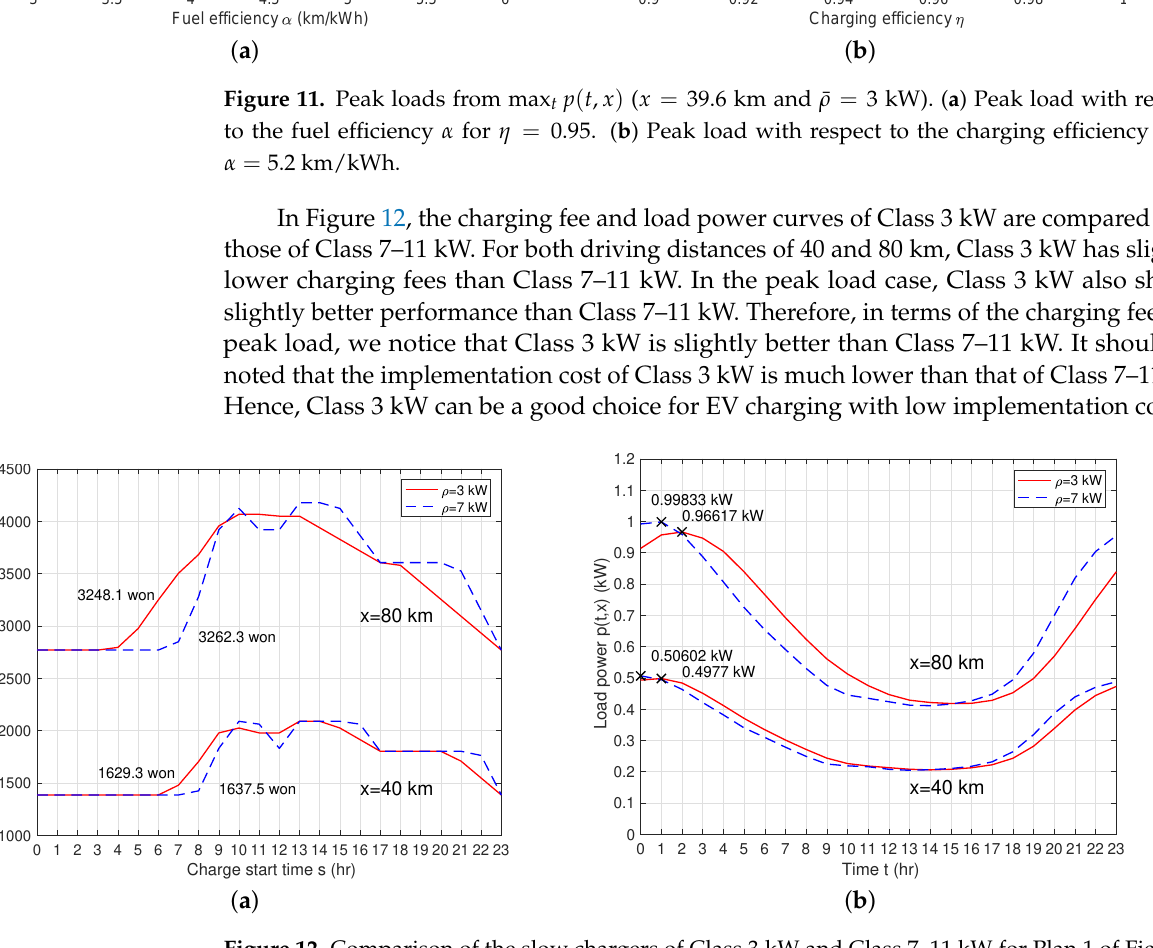
Figure 12. Comparison of the slow chargers of Class 3 kW and Class 7–11 kW for Plan 1 of Figure 3 ( x = 39.6 km, α = 5.44 km/kWh, η = 0.95, and KRW 1000 is USD 0.83). ( a ) Charging fee B ( s , x ) and E { B ( S , x ) } . ( b ) Load power p ( t , x ) and the peak load max t p ( t , x )